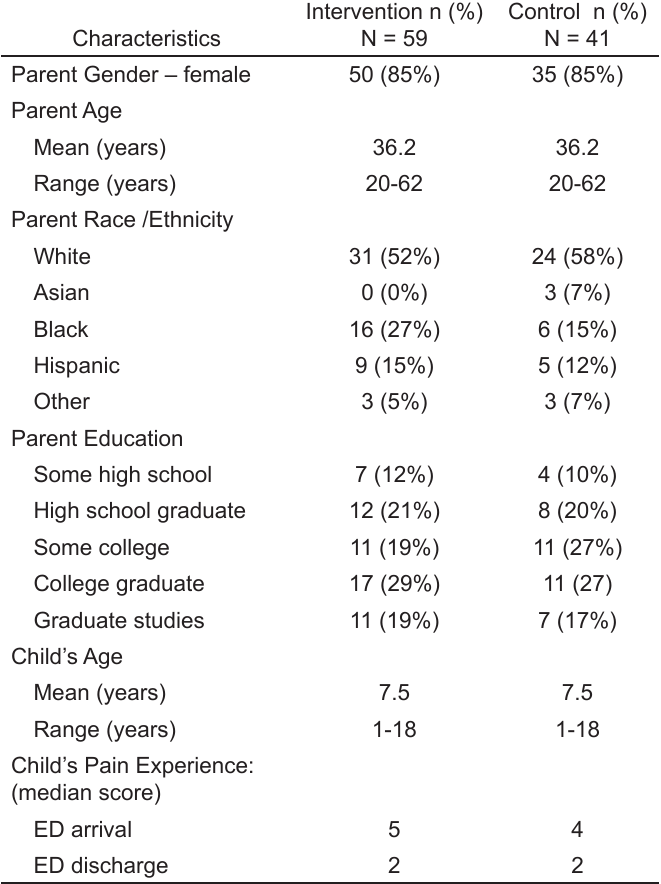
Table 2. Baseline characteristics for the two